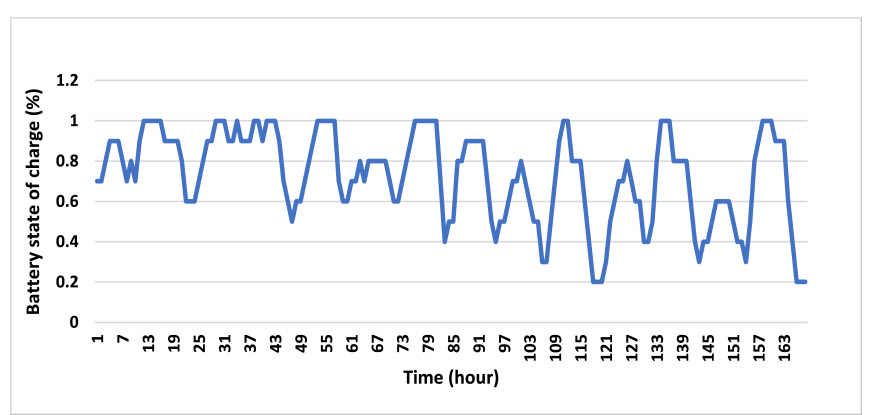
Figure 13. Battery state of charge during a week in the dry season: Case 2.